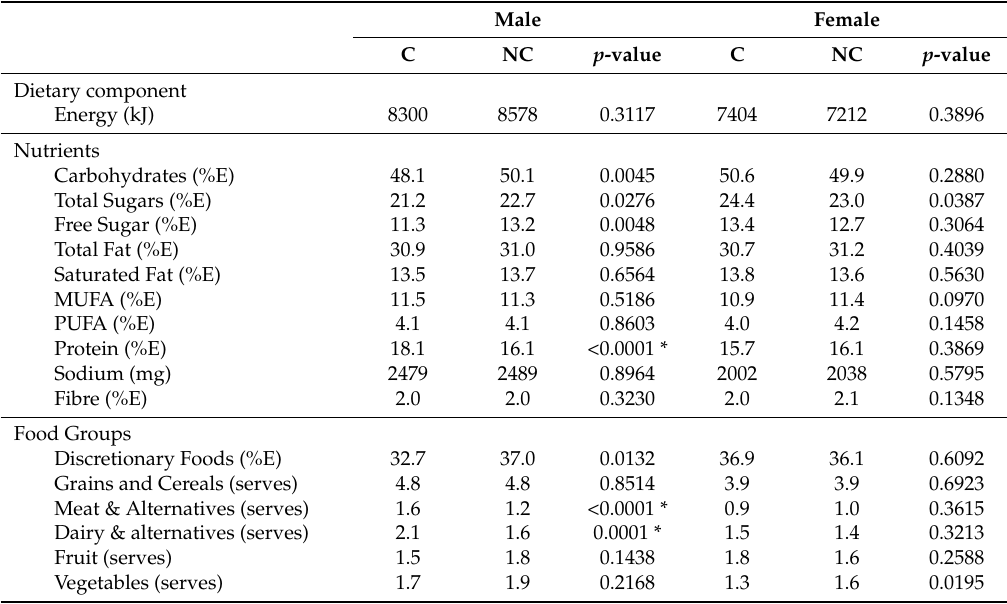
Table 3. Dietary intake of children (aged 2–18) non-nutritive sweeteners (NNS) consumers and non-consumers.